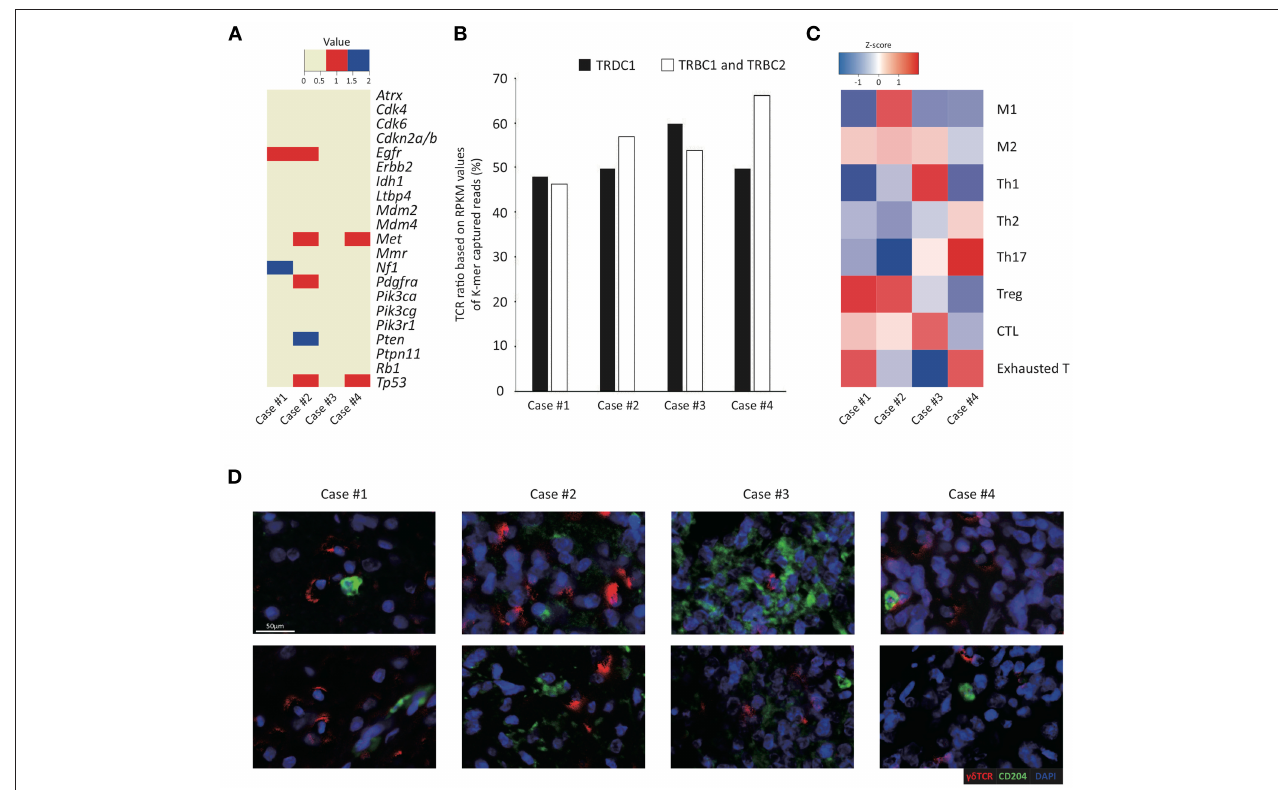
FIGURE 1 | Tumor-infiltrating γδ T cells and immune profiles in four GBM cases. (A) Summary of mutational changes in 21 GBM-related genes across sequenced samples. Red and blue denote single nucleotide variant events and indel events, respectively. (B) RPKM values (y-axis) of TCRB and TCRD captured reads from RNA-seq data of four cases (x-axis) are shown as a column chart. (C) The heatmap illustrates the z-score of normalized Gene Set Variable Analysis (GSVA) enrichment scores of a variety of curated immune gene signatures based on whole transcriptome sequencing data of four GBM samples analyzed in this study. The z-scores are calculated based on average and standard deviation of GSVA enrichment scores of each patient, indicating relative enrichment scores of immune gene sets within each patient. The scale of z-score is shown: red illustrates high enrichment and blue illustrates low enrichment. (D) The representative images of the multiplex immunohistochemistry analysis of four GBM patient tissue samples stained for γδ TCR in red and CD204 in green. Scale bar, 50 µ m.